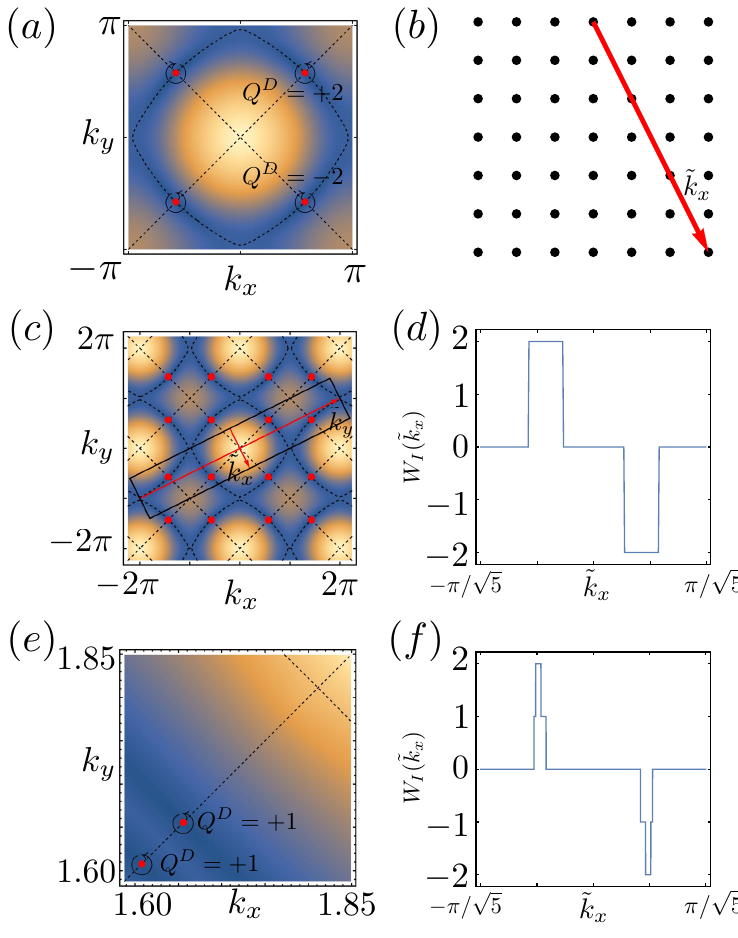
(cid:113) ( k ) for the Hamiltonian (48) ( k ) + ∆ 2 ξ 2 I I